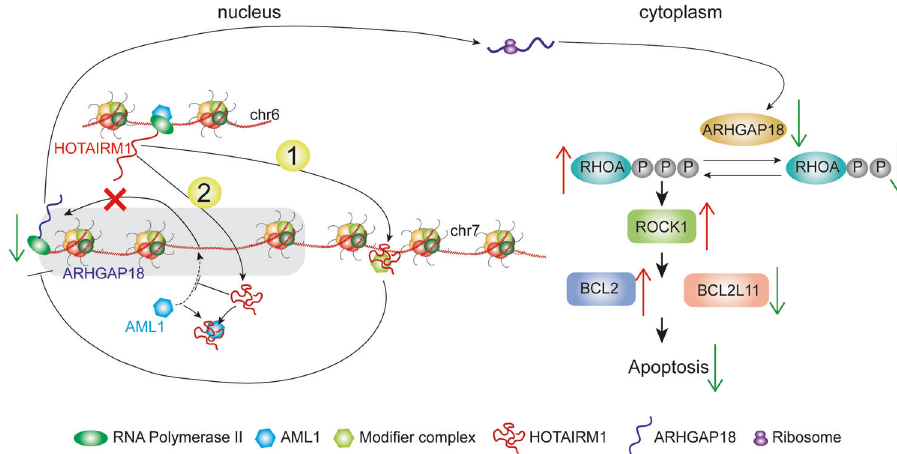
Fig. 8 Schematic diagram of HOTAIRM1 working mechanism. The transcription of HOTAIRM1 is regulated by the binding of AML1 to its promoter region. As a trans factor, HOTAIRM1 inhibits the transcription of ARHGAP18 in the nucleus in two ways: (1) It binds to the chromatin site downstream of ARHGAP18 gene to inhibit the transcription of ARHGAP18. HOTAIRM1 may interact with other proteins to form a complex. (2) It binds to the AML1 protein to keep AML1 away from its target chromatin region, thereby preventing the gene transcription activity of AML1. After the transcription of ARHGAP18 is suppressed, its protein expression level is decreased, which increases the active form of RhoA- GTP and activates the RHOA/ROCK1 signaling pathway. Subsequently, the increase of the antiapoptotic gene BCL2 and the decrease of the proapoptotic gene BCL2L11 eventually lead to the decrease of